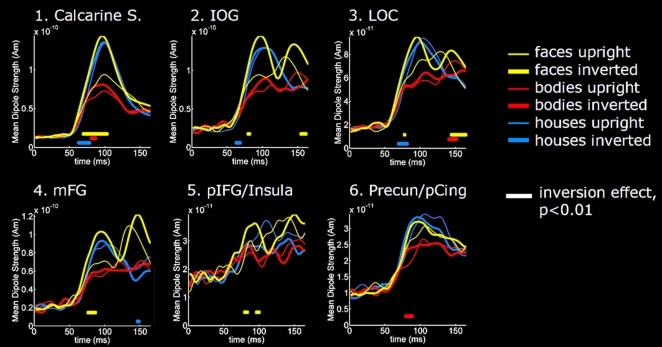
Time courses of current strength from selected regions.Grand average (n = 9 subjects) time courses of estimated currents extracted from six regions that showed significant Inversion Effects indicated on the inflated brains in the top panel, i.e. the Calcarine Sulcus (1), IOG (2), LOC (3), mFG (4), pIFG/Insula (5), and the Precuneus/posterior Cingulate (6) for Upright and Inverted Faces (yellow), Bodies (red) and Houses (blue). The time instants at which significant differences occur between Upright and Inverted conditions are indicated at the level of p<0.01 (paired t-tests, n = 9, df = 8) by horizontal bars with color corresponding to category. Abbreviations: Calcarine S. = Calcarine Sulcus; IOG = Inferior Occipital Gyrus; LOC = Lateral Occipital Cortex; mFG = mid-Fusiform Gyrus; pIFG = posterior Inferior Frontal Gyrus; Precun = Precuneus; pCing = posterior Cingulate Gyrus.